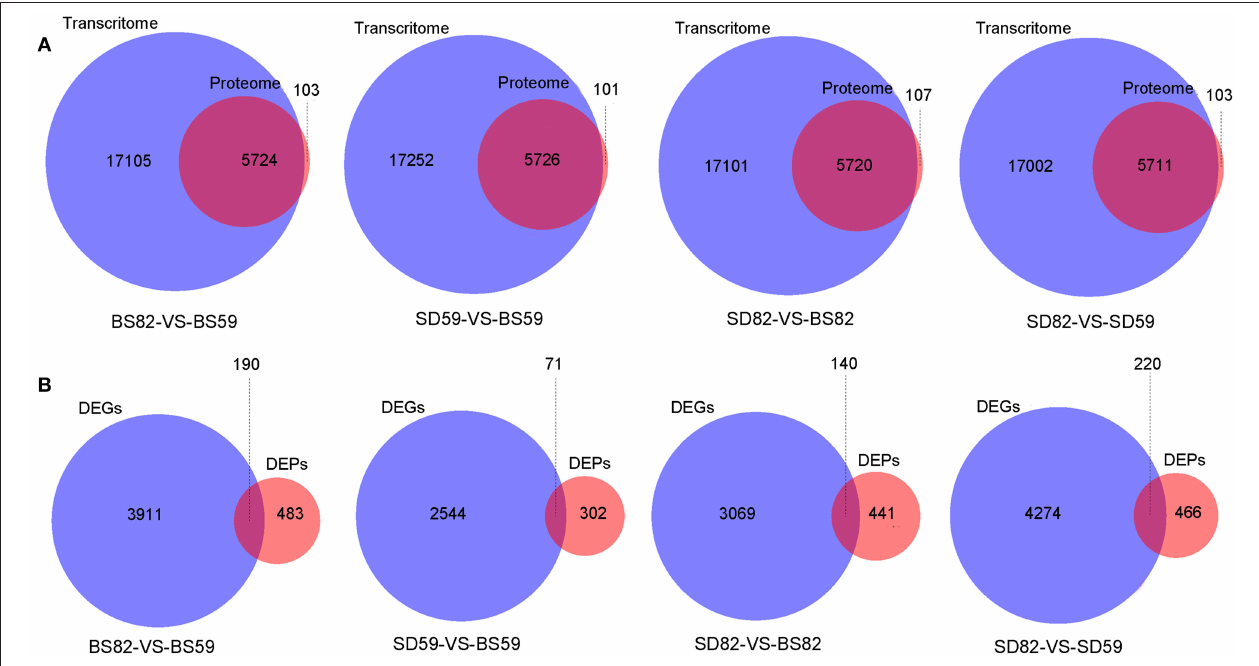
FIGURE 3 | Venn diagrams of the correlation genes between proteome and transcriptome. (A) Venn diagram of identification gene number between the proteome and transcriptome. (B) The Venn diagram of DEG (differentially expressed gene) and DEP (differentially expressed protein) number from the proteome and transcriptome at four comparative